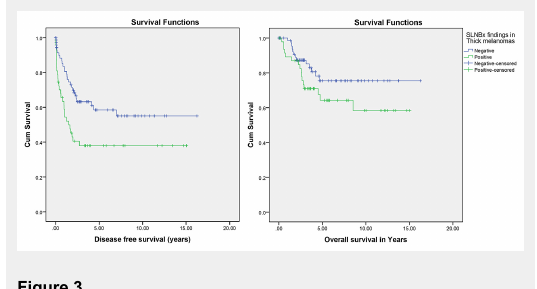
Effect of sentinel lymph node biopsy (SLNBx) result on disease-free and overall survival in thick melanoma (p = 0.008 and p = 0.13, respectively).